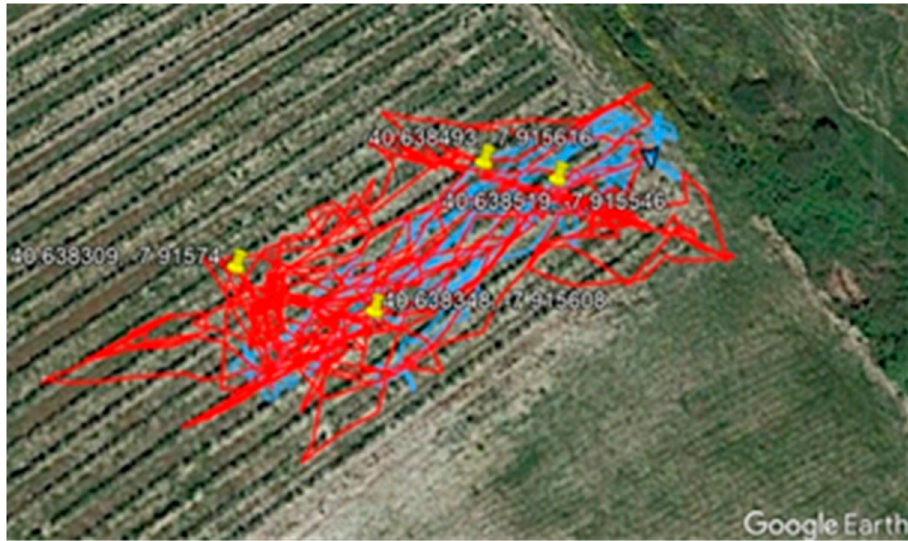
Figure 7. SheepIT vs. GPS animal localization.